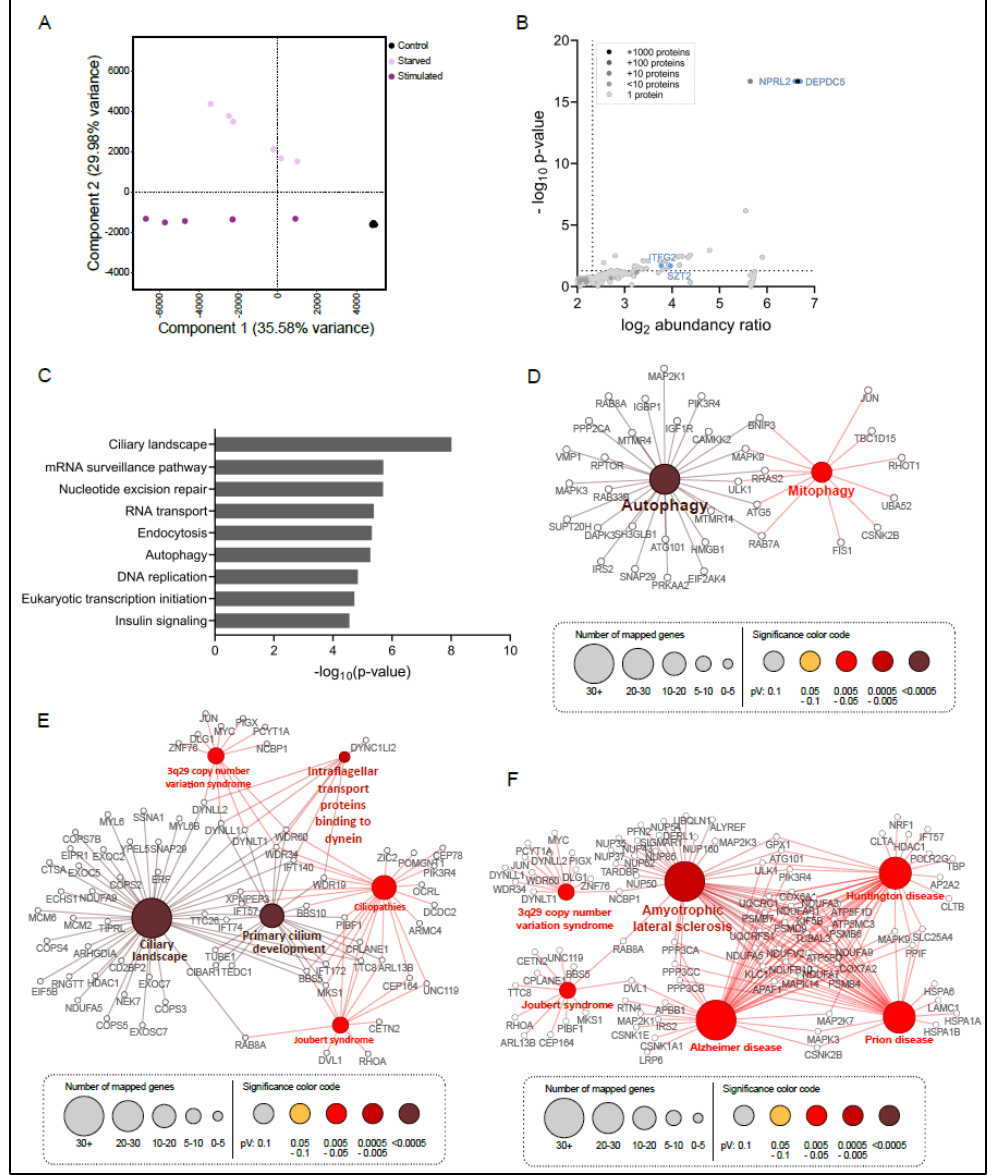
Figure 2. Characterization of the SZT2 interactome. ( A ) Principal component analysis (PCA) of the abundancies of all proteins identified in the interactome of SZT2 under starvation (light violet) or stimulation (violet) and of the GFP control (black). ( B ) Zoom in of volcano plot of all identified proteins interacting with SZT2 or the GFP control (see Figure S2A for whole volcano plot). The gray color scale depicts the number of proteins that have the same abundance and p -value. Proteins significantly binding to SZT2 have a p -value below 0.05 and an abundance ratio of 5 over the GFP control (within dotted lines). Representative components of KICSTOR and GATOR1 complexes are depicted in blue labeled with their protein names. ( C ) Summary of Top9 processes (KEGG pathway and WikiPathway) associated with proteins binding with high affinity to SZT2. Relevant processes were selected based on their -log10 ( p -value). Maps of ( D ) autophagy, ( E ) cilia- associated terms, ( F ) neurological disorder-associated terms, with the depiction of proteins, which have a significantly higher affinity to bind to SZT2 than to the GFP control. The node size correlates with the number of mapped proteins per term and the node color with the significance of this term.